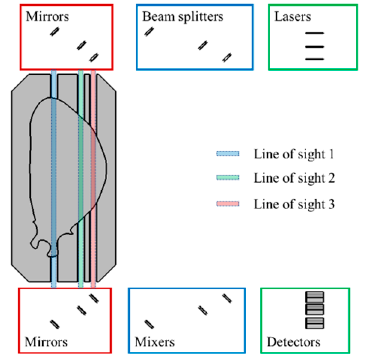
Figure 3. Interferometer simulation geometry.